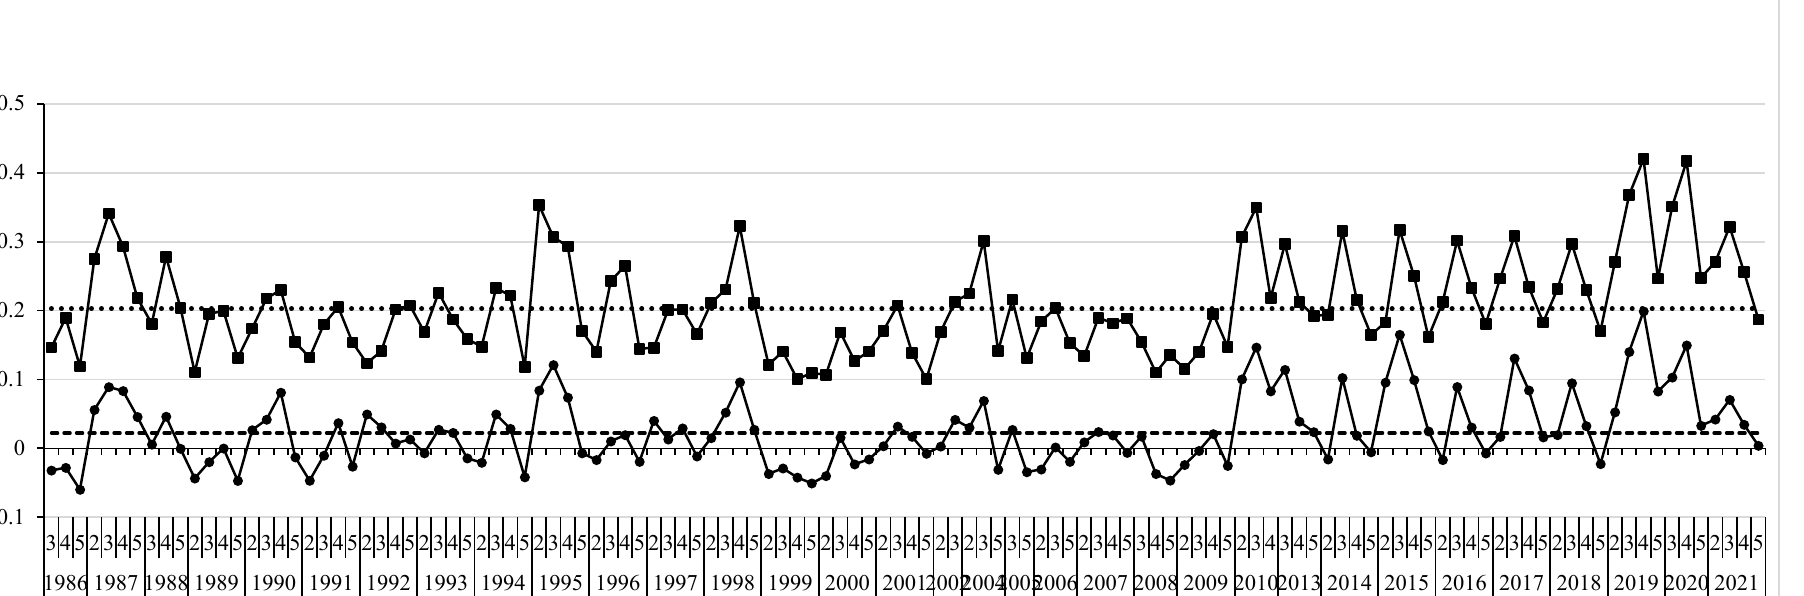
Figure 4. The spatiotemporal phenological profile of the agricultural land-use type using monthly average NDVI and NDMI values of the growing seasons (i.e., February to May) for the period 1986–2021 as extracted from Landsat-5 and Landsat-8 data in the Yarmouk River Basin (YRB).